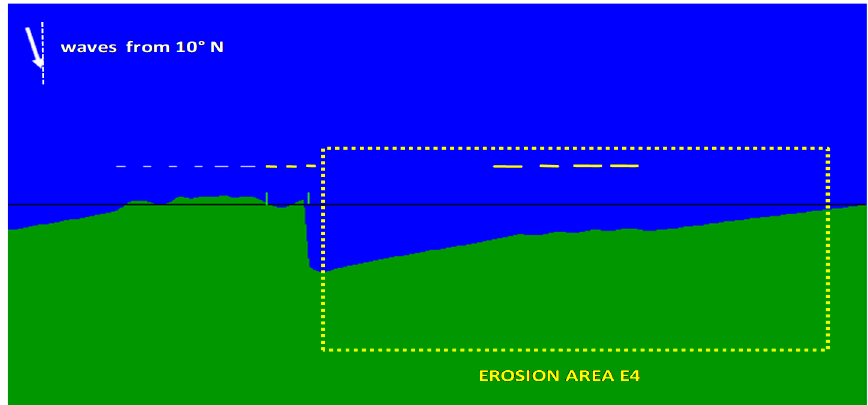
Figure 15. GENESIS model outputs at S E4 (K1 = K2 = 0.1).